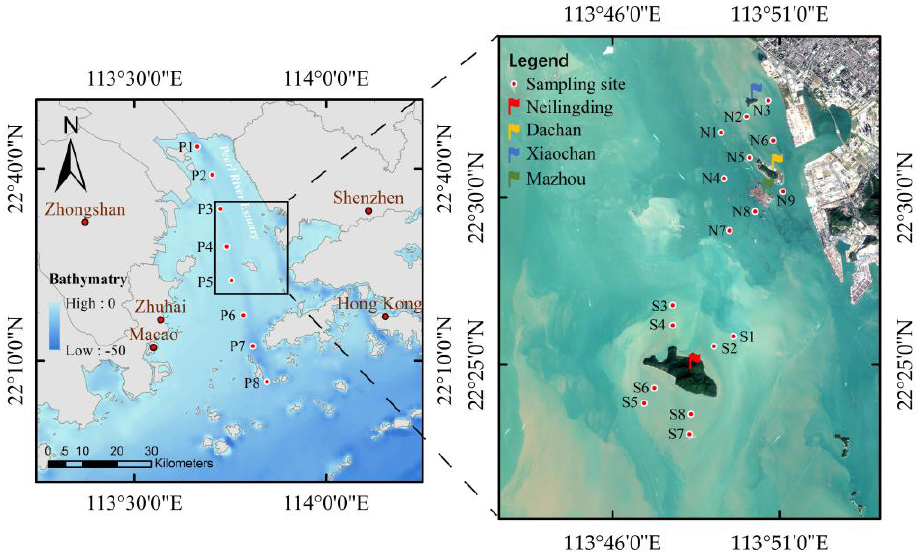
Table 1. Observation stations with respect to three trips, including IOP, PSD, and AOP data.